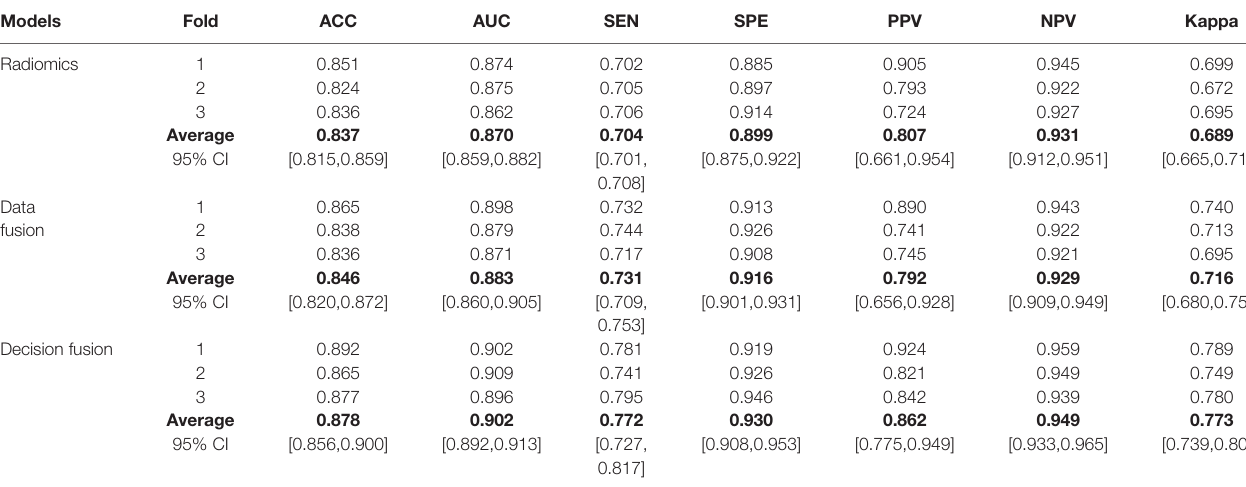
TABLE 2 | Three-fold cross-validation performance of multimodal prediction models using radiomics, data fusion strategy, and our proposed MMIDFNet